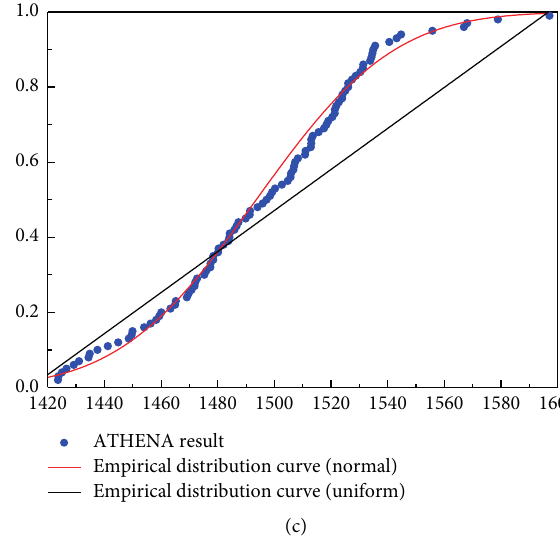
Figure 9: CDFs and fitted normal distribution results with inputs of uniform distribution. (a) SRS. (b) LHS. (c) LHS-SVDC.